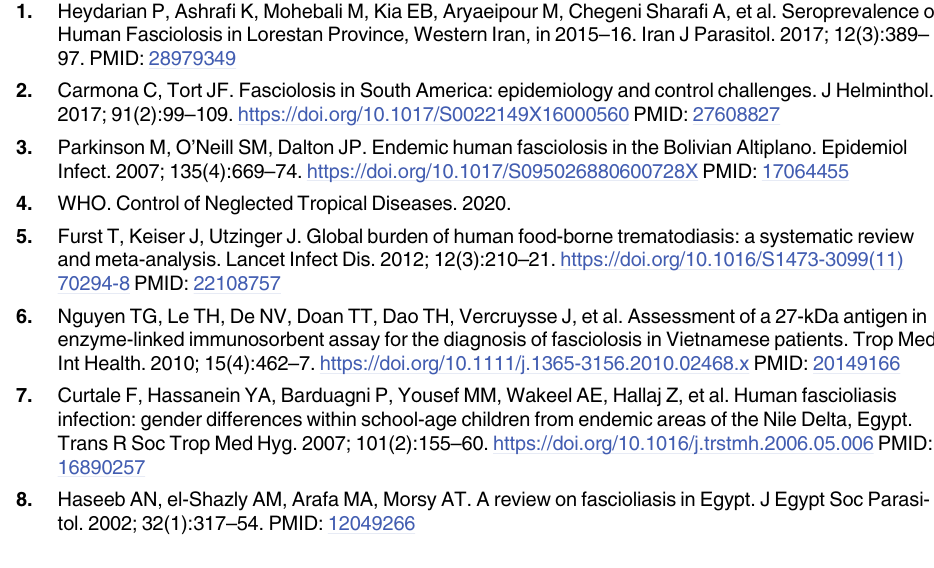
S5 Table. Multiple regression analysis of factors associated with Height for Age Z score in Ancahuasi